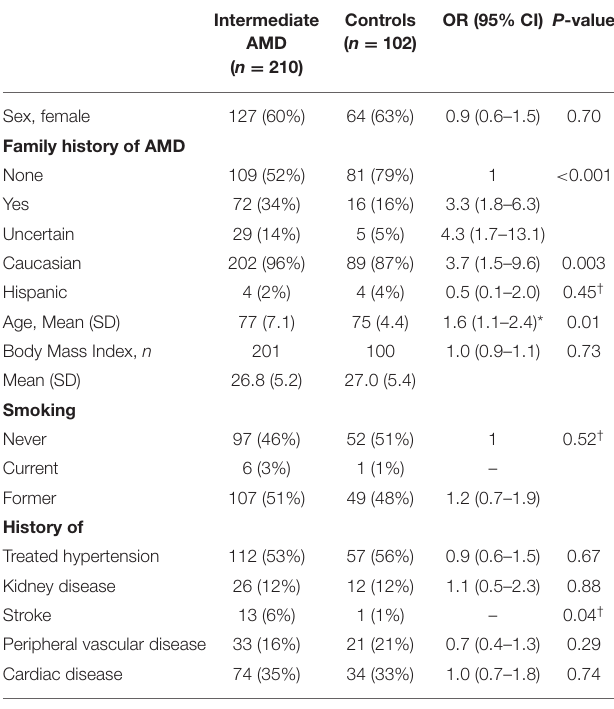
TABLE 1 | Differences in clinical characteristics between subjects with intermediate AMD and controls.